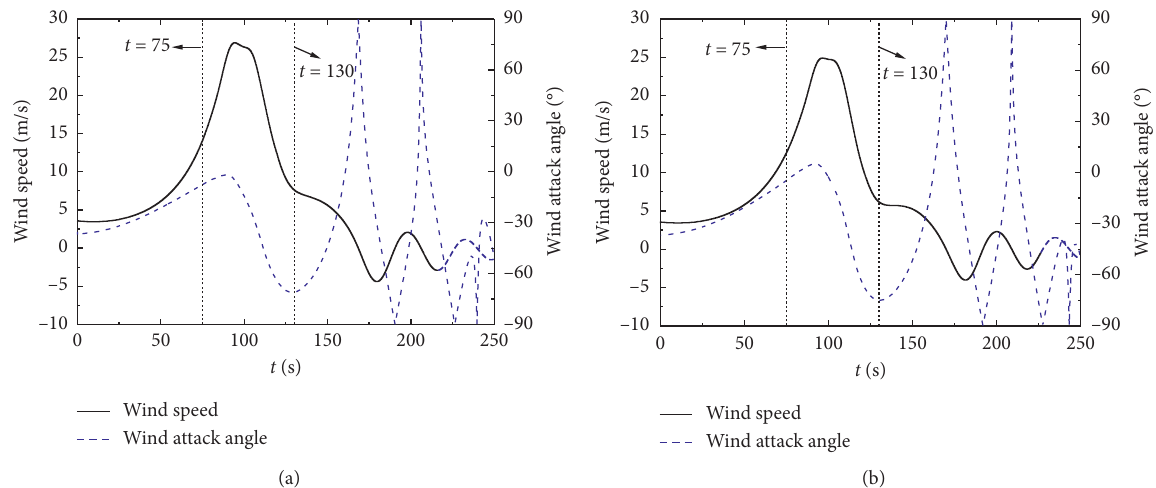
Figure 15: Synchronous comparisons of time-history curves of wind speed and wind attack angle in the flat terrain. (a) The midspan point. (b) The 1/4 span point.